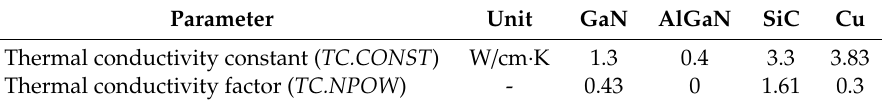
Figure 3. Thermal conductivity profiles for the GaN, SiC, and Cu materials. Table 3. Thermal constants used for the thermal conductivity model.